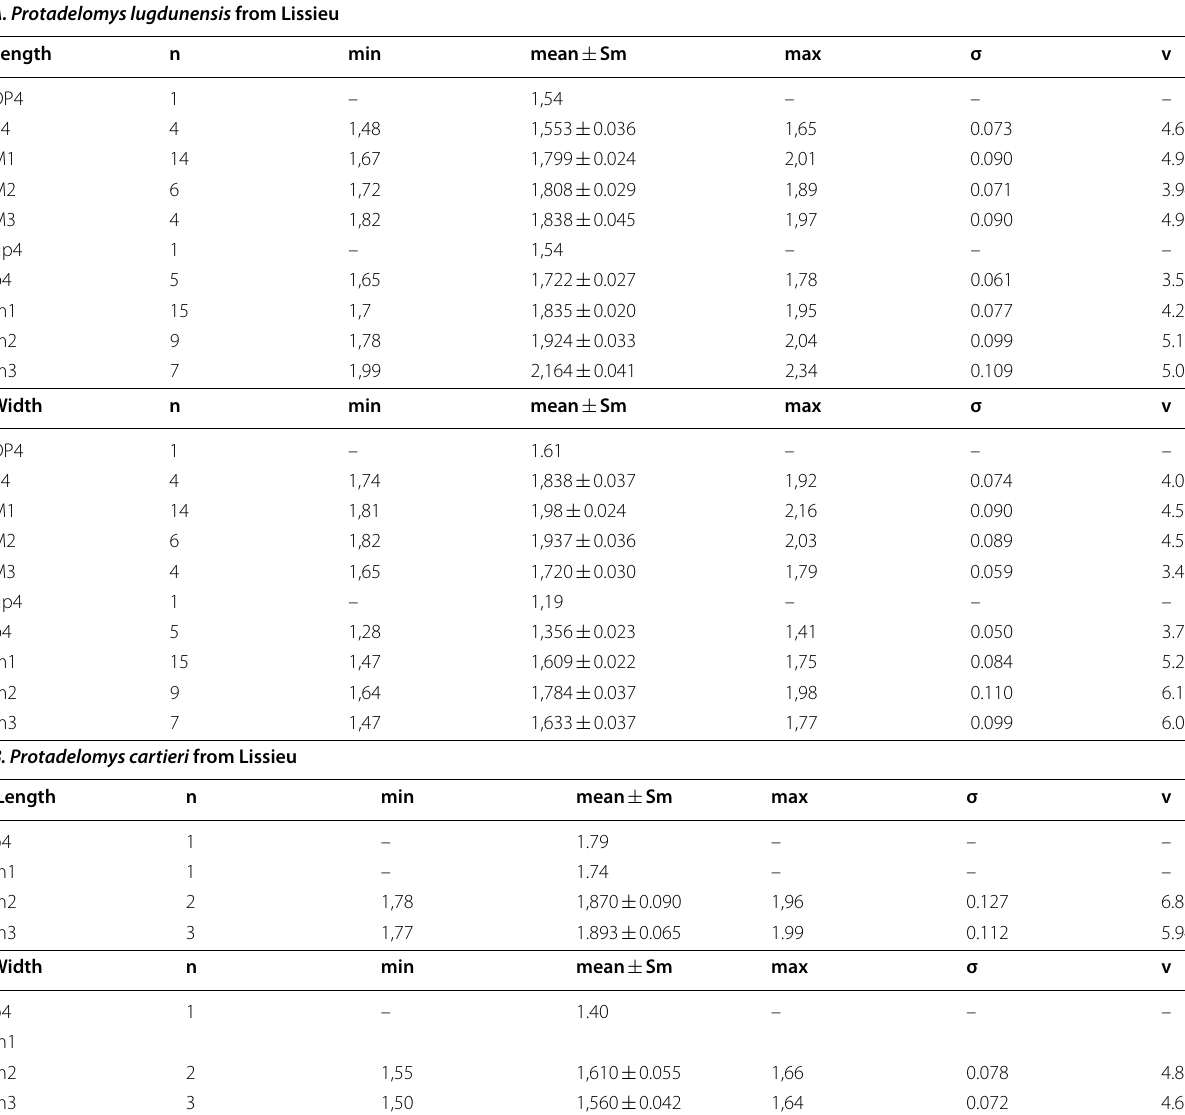
Table 2 Range of the size variations (length and width: min., max.; average loci of teeth of Protadelomys lugdunensis Hartenberger, 1969 and B. length and width for some loci only of Protadelomys cartieri Hartenberger, 1969 from Lissieu (MP 14; Rhône,